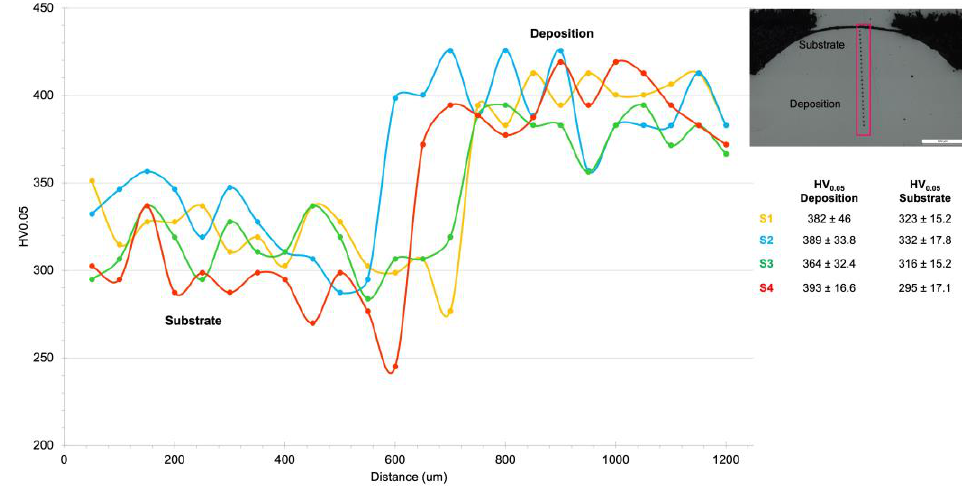
Figure 13. Vickers microhardness profiles.